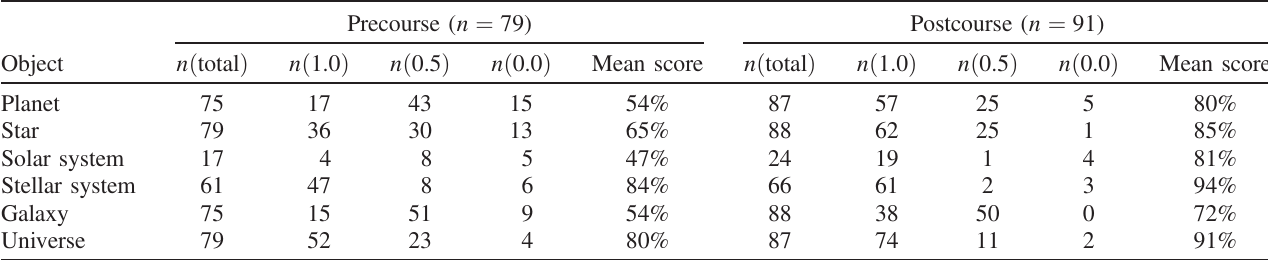
TABLE VIII. Student scores on the explaining task, for the full pre- and postcourse